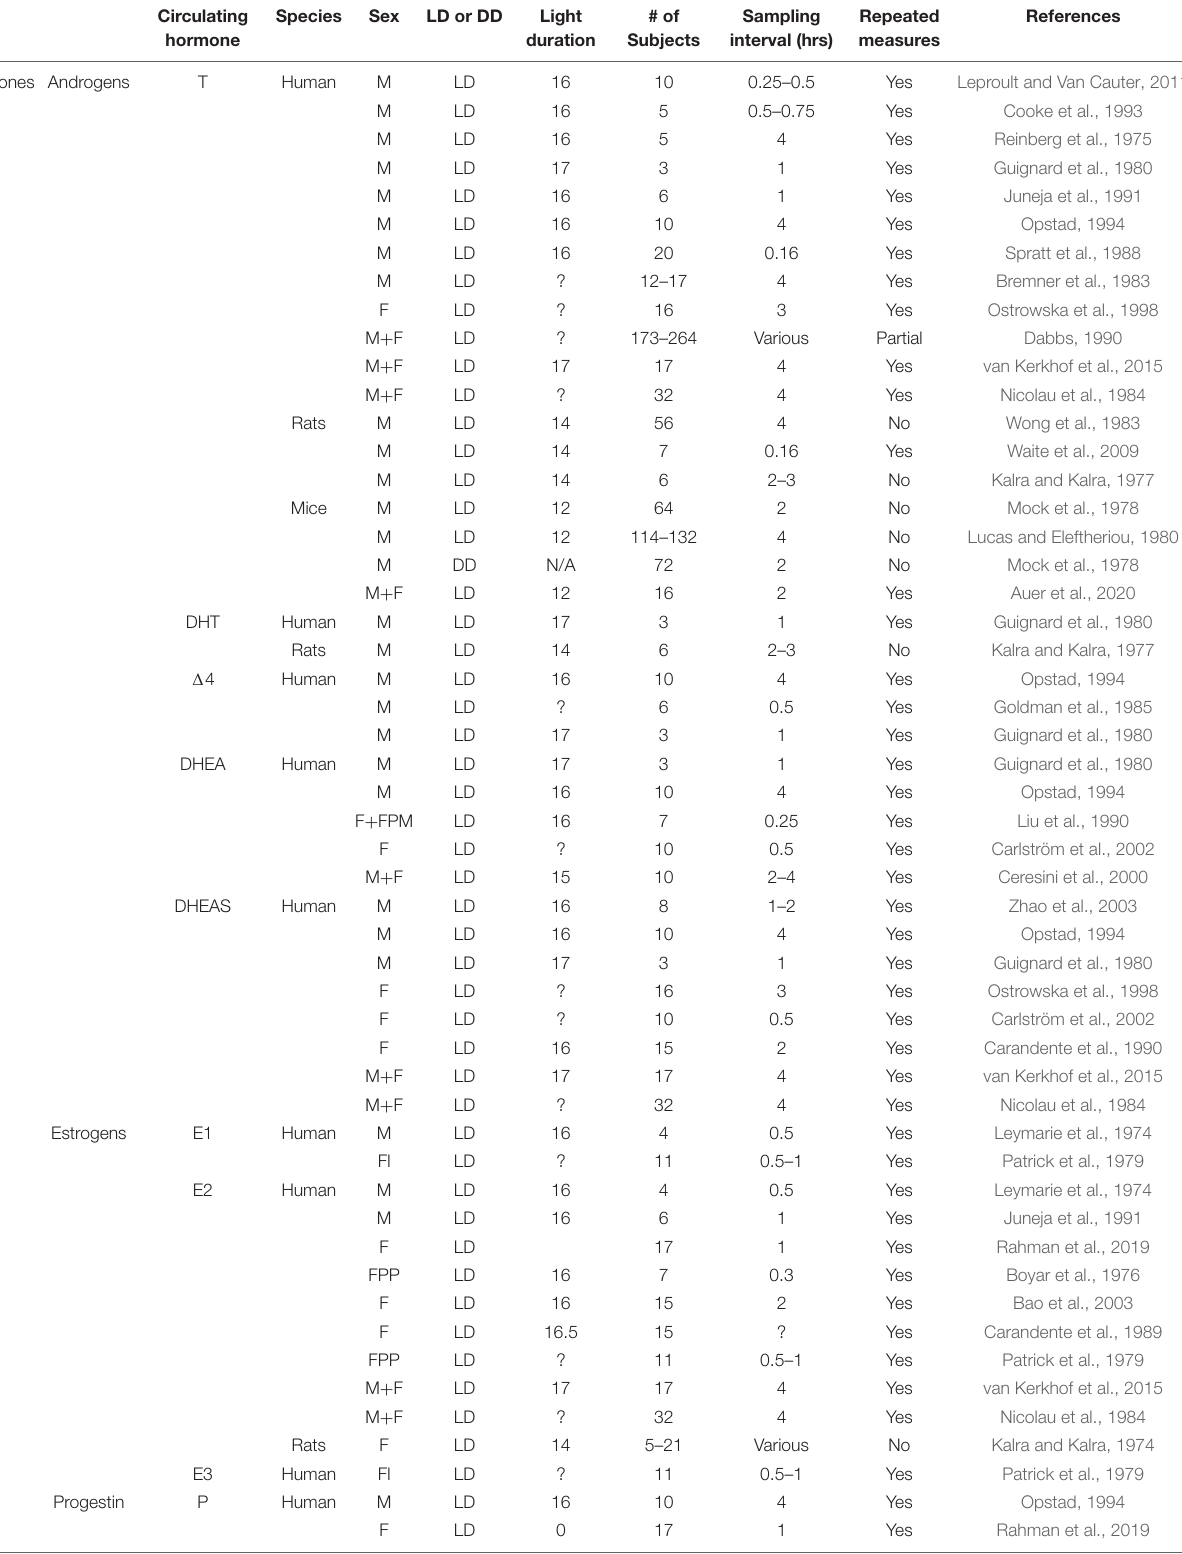
TABLE 2 | Experimental design in studies of daily hormone